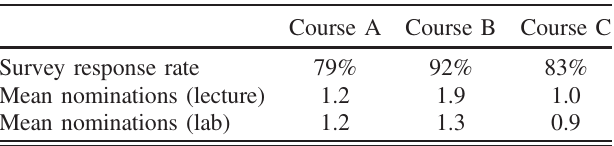
TABLE II. Survey response rates and mean number of nom- inations made per student. The survey response rate is the percent of enrolled students who completed the survey. The mean number of nominations is the average number of peers ’ names that each student